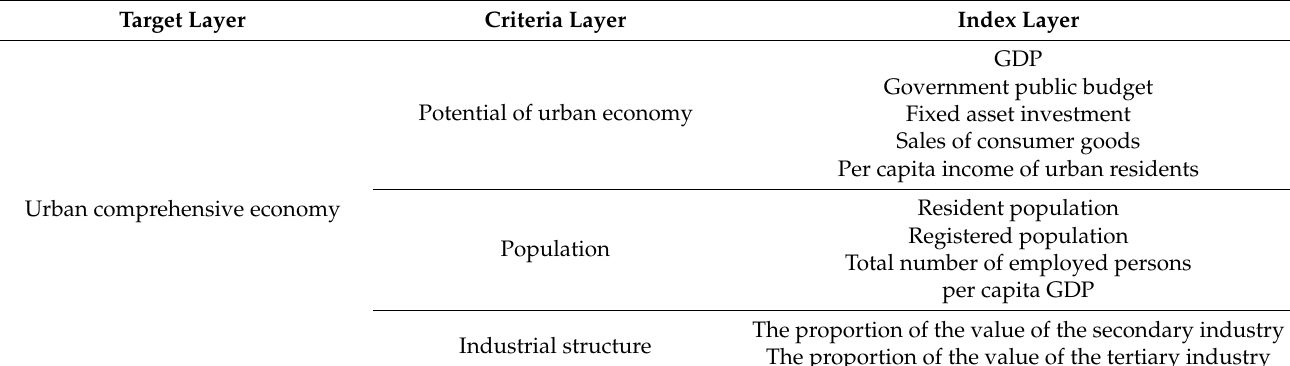
Table 1. Index system of the urban comprehensive